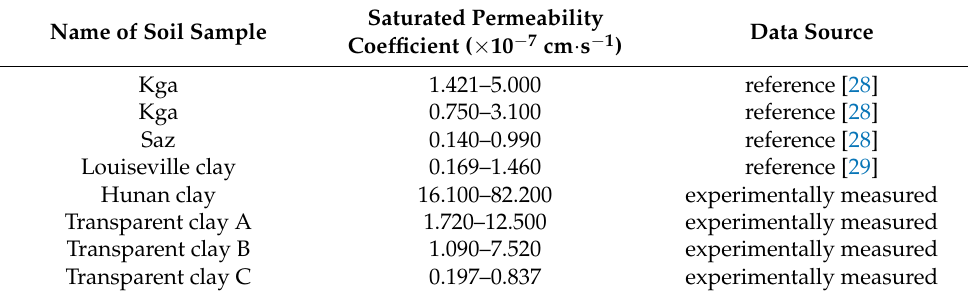
Table 1. Comparison of saturated permeability coefficients of various types of clays.